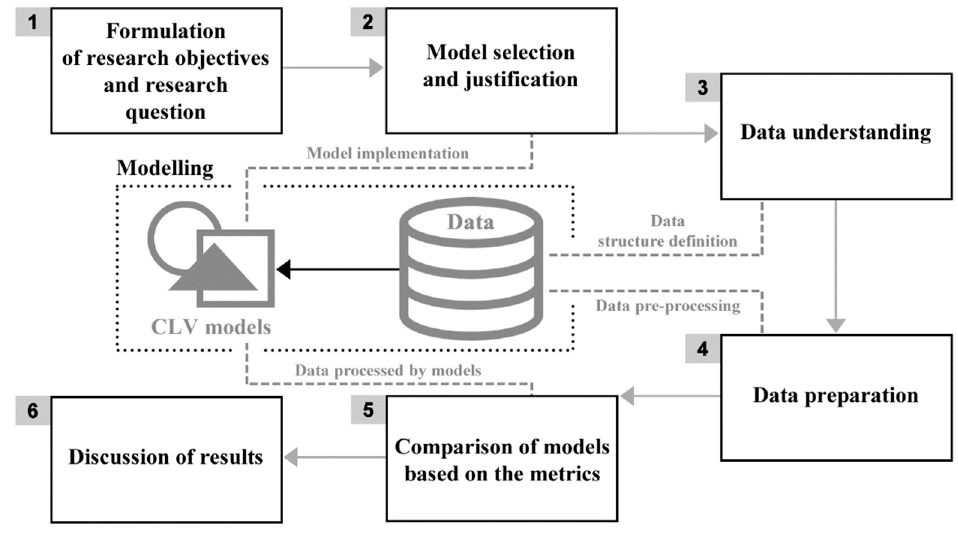
Figure 1. Methodology of the research with six phases. Source: Authors.